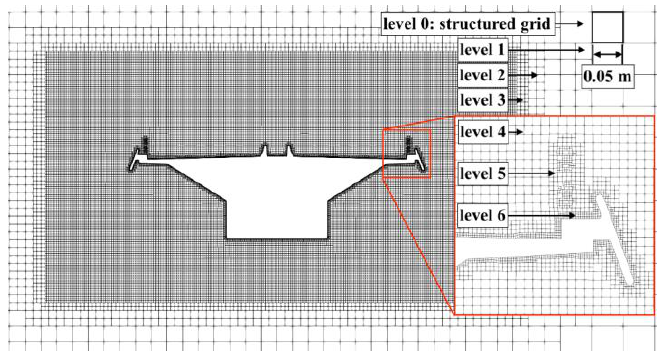
Figure 12. Details of mesh No.3.